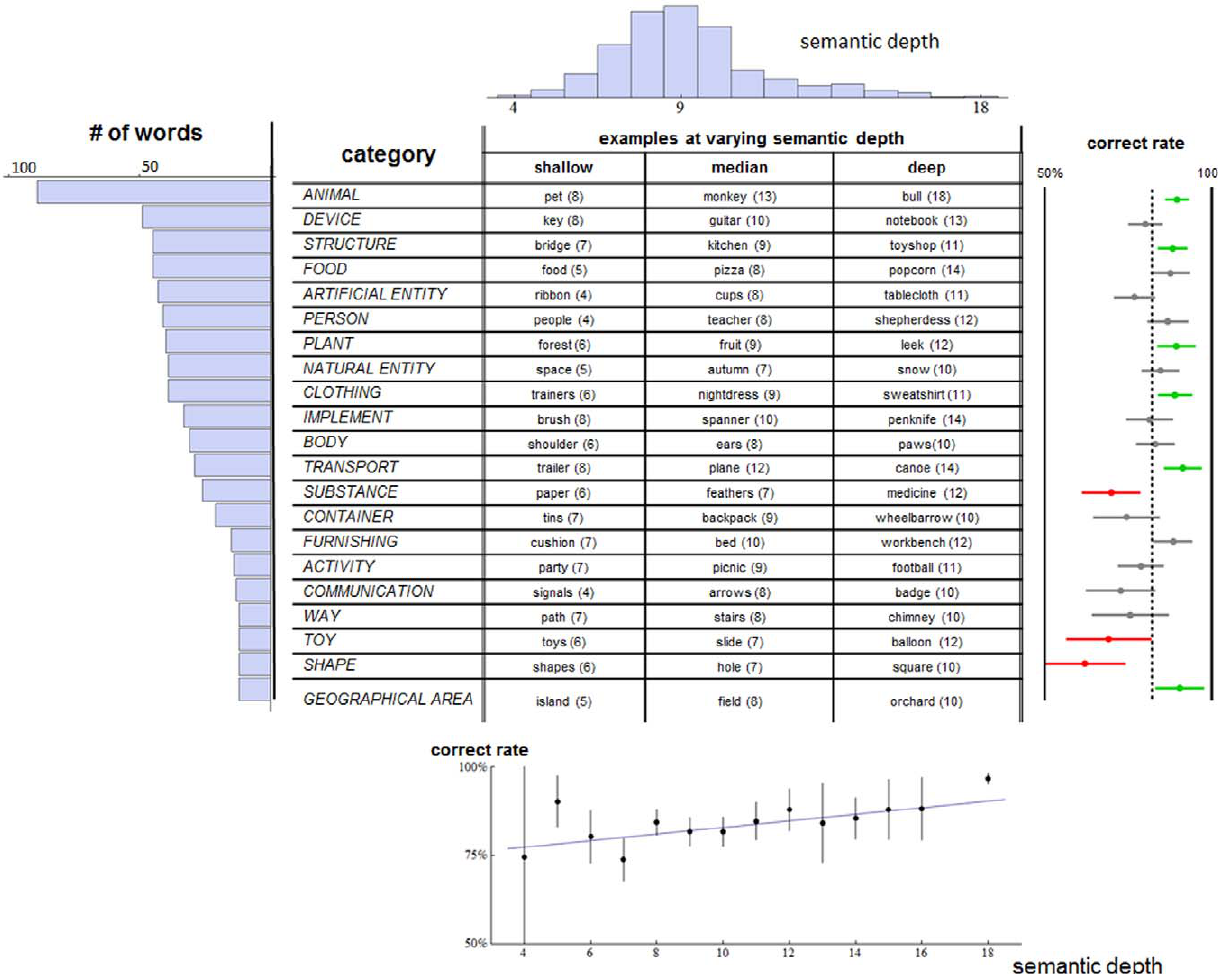
words. Comparison of scores A and B in Table 1 shows that oBIFs perform at least as well as SIFT. The assessments of sensitivity to image source and texture feature were made using reduced sets of categories because of data availability. Potentially performance on these reduced sets could be different than the full sets, but the